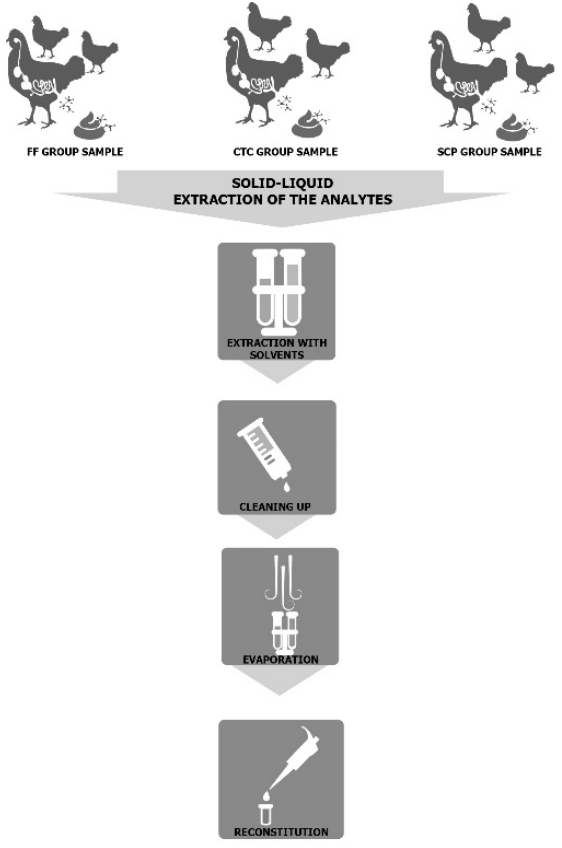
Figure 1. Solid-liquid extraction of FF, CTC, and SCP analytes from group samples of broiler chicken droppings.